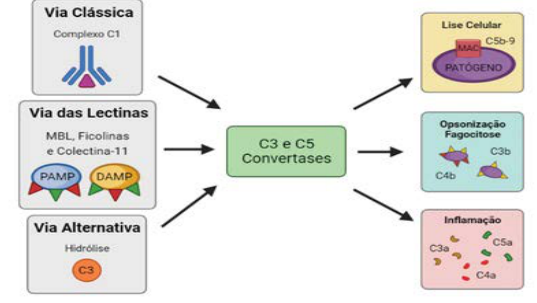
fIGuRE 1 – Complement system activation